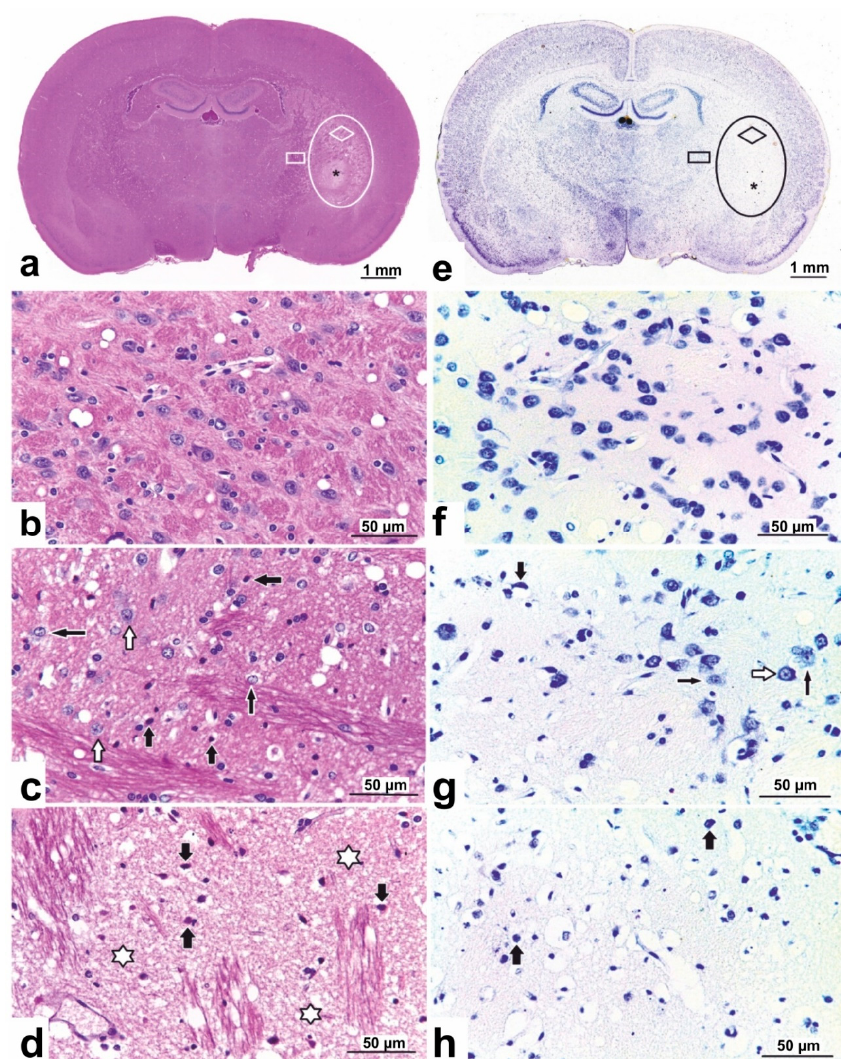
Figure 1. Photomicrographs of haematoxylin and eosin-stained ( a – d ) and Nissl-stained ( e – h ) sections of the rat brain in tMCAO model conditions. ( a , e ) Serial coronal rat brain sections at the level of − 2.0 mm from the bregma. Rectangles indicate the normal tissue in the medial region of the caudoputamen. The oval indicates the damaged area involving the lateral region of the caudoputamen nucleus of the right hemisphere. Asterisks indicate necrotic tissue in the central core of an infarct. ( b , f ) High-magnification images of the normal tissue in the areas of panels ( a , e ) marked with a rectangle. ( c , g ) Areas of panels ( a , e ) marked with a rhomb. Hypoxic damage to neurons, with pyknotic nuclei and pericellular oedema indicated in the ischaemic zone (thick black arrows); decrease of nuclear basophilia and Nissl substance in the neurons (thin black arrows); intact neurons (white arrows). ( d , h ) Areas of panels ( a , e ) marked with asterisks. Ischaemic necrosis of the brain tissue in the central core of an infarct; destruction of the neuropil (white asterisks); dead “pyknotic” neurons (thick black arrows), Nissl substance disappearing.